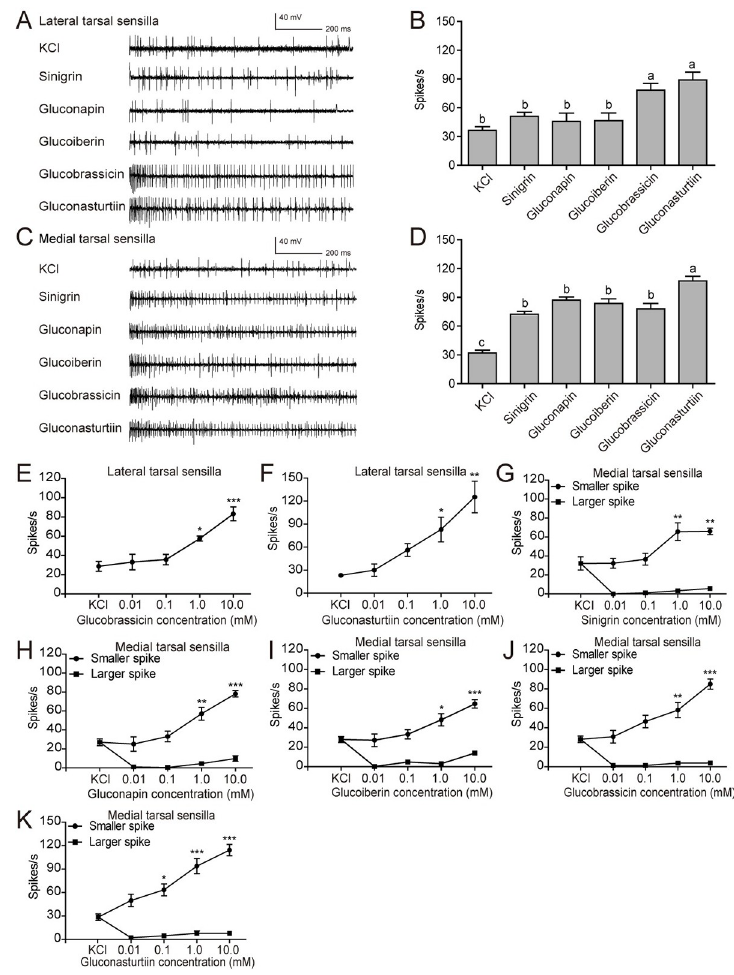
Fig 4. Response properties of taste sensilla on the fifth foreleg-tarsi of male P . rapae to glucosinolates. ( A ) Representative responses and ( B ) spike frequencies of lateral tarsal sensilla ( n = 9–16); ( C ) representative responses and ( D ) spike frequencies of medial tarsal sensilla ( n = 12–18). All tested glucosinolates were at 10 mM, and 2 mM KCl was used as control. ( E , F ) Dose-response curves of lateral tarsal sensilla to glucobrassicin ( n = 6–7) and gluconasturtiin ( n = 3). ( G - K ) Dose-response curves of medial tarsal sensilla to sinigrin ( n = 6–7), gluconapin ( n = 6–8), glucoiberin ( n = 5–7), glucobrassicin ( n = 7–8), and gluconasturtiin ( n = 7), respectively. Data are presented as mean ± SEM. One-way ANOVA with Tukey HSD test was used. Different letters labeled indicate significant differences. � P < 0.05, �� P < 0.01, ��� P < 0.001, compared with KCl control.